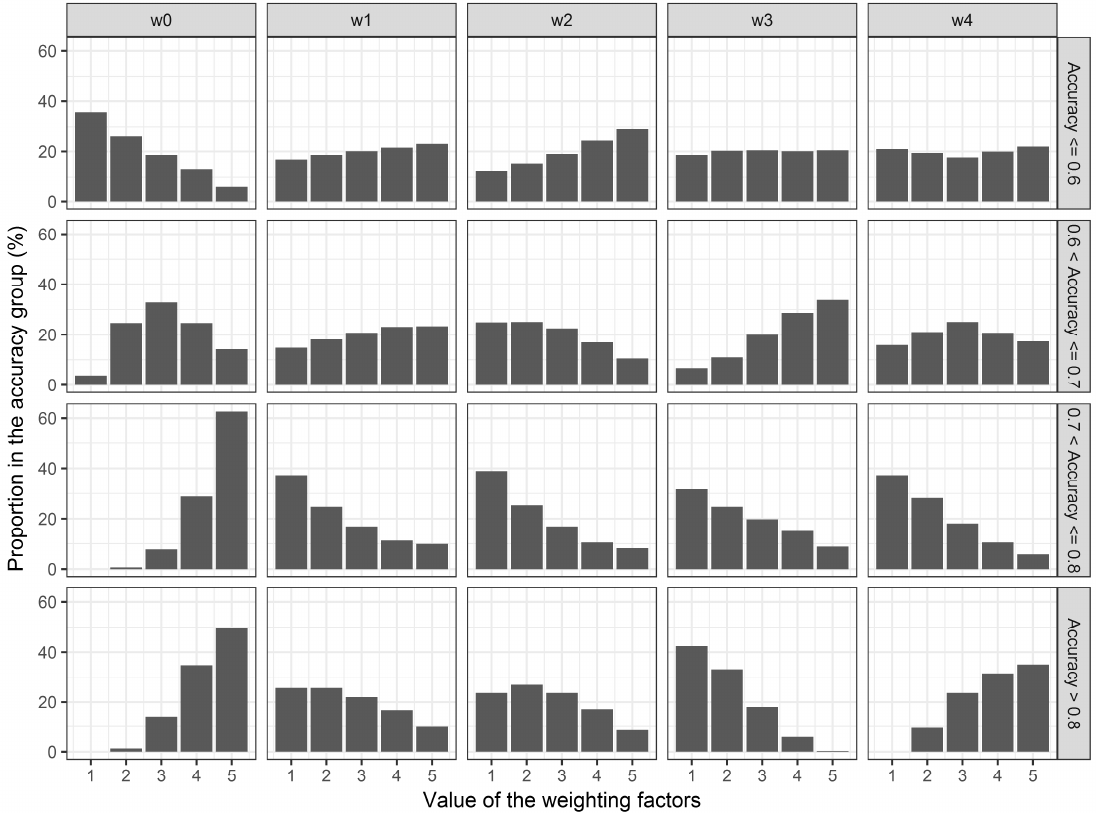
Figure 8. The value distributions of all w factors in each accuracy group (accuracy <= 0.6, 0.6 < accuracy <= 0.7, 0.7 < accuracy <= 0.8, accuracy > 0.8), where w0, w1, w2, w3, and w4 are the weighting factors of the change magnitudes of SC (spectral correlation), PAC, BC, RCR, and ZCR,